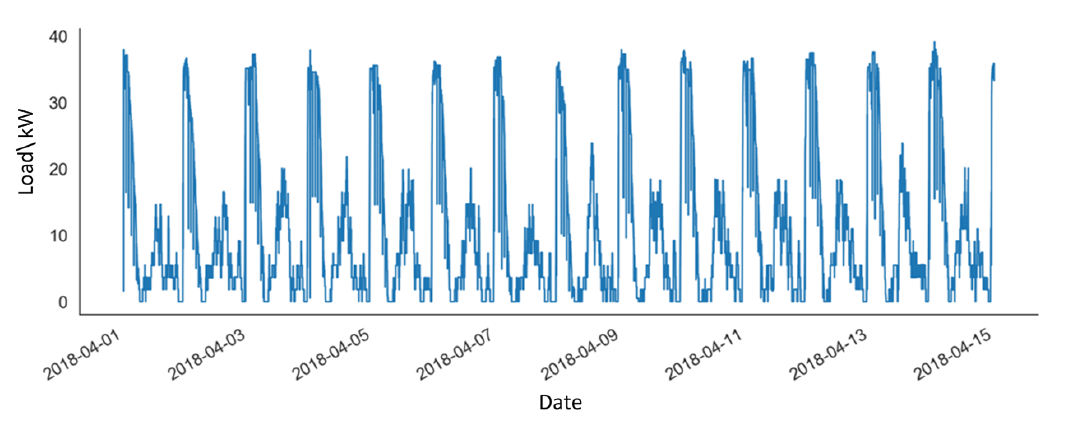
Figure 6. Load curve for half a month